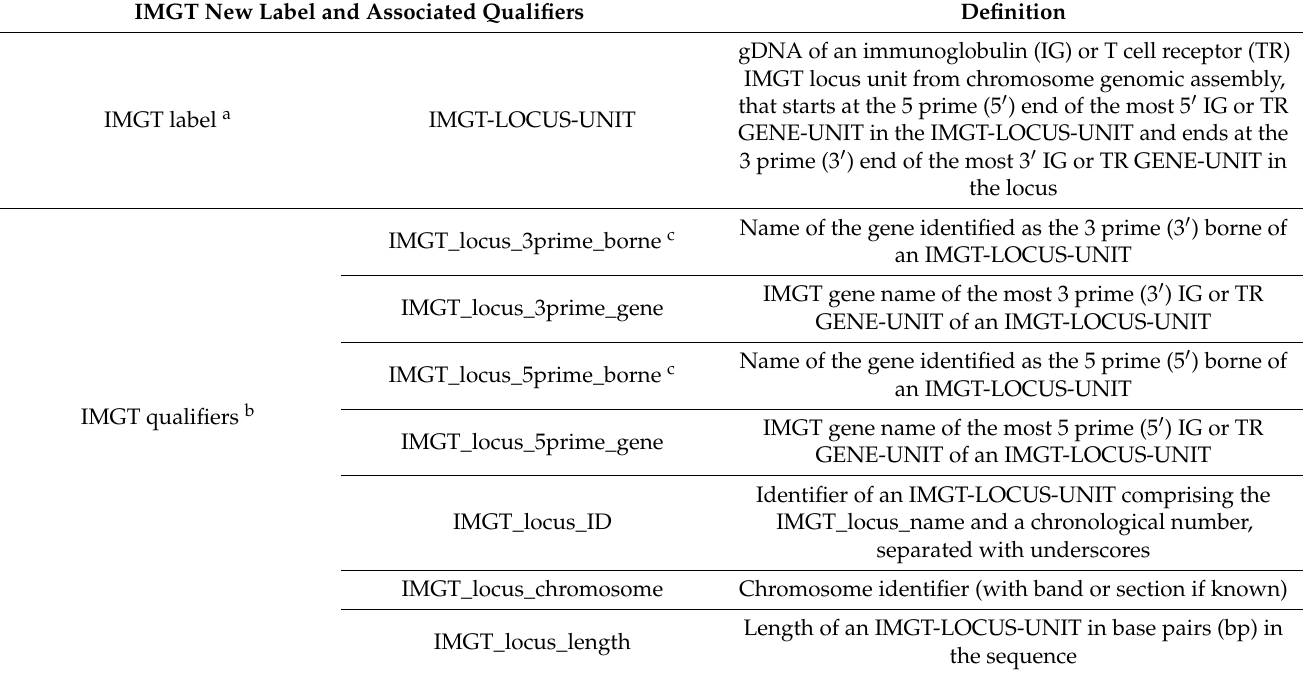
Table 1. The IMGT-LOCUS-UNIT label and its associated qualifiers and